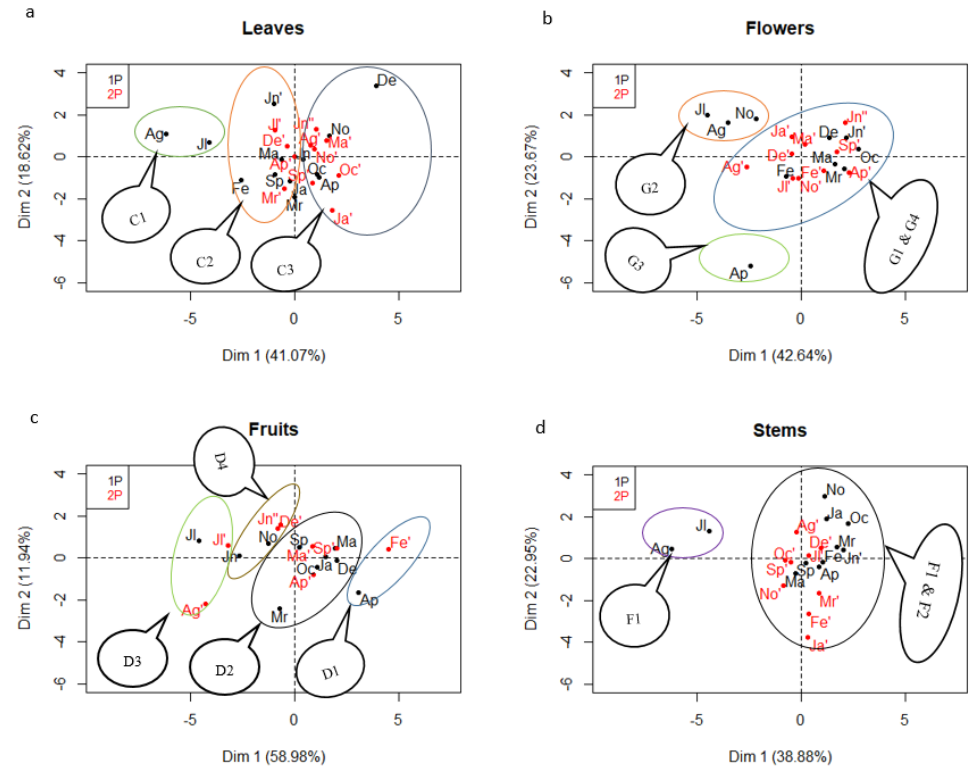
Figure 4. Individuals map of PCA and clustering of each organ. 1P (in black): first period, 2P (in red): second period. ( a ) C1, C2, and C3 are cluster 1, 2, and 3 of leaves, respectively. ( b ) G1, G2, G3, and G4 are cluster 1, 2, 3, and 4 of flowers, respectively. ( c ) D1, D2, D3, and D4 are cluster 1, 2, 3, and 4 of fruits, respectively. ( d ) F1, F2, and F3 are cluster 1, 2, and 3 of stems, respectively.